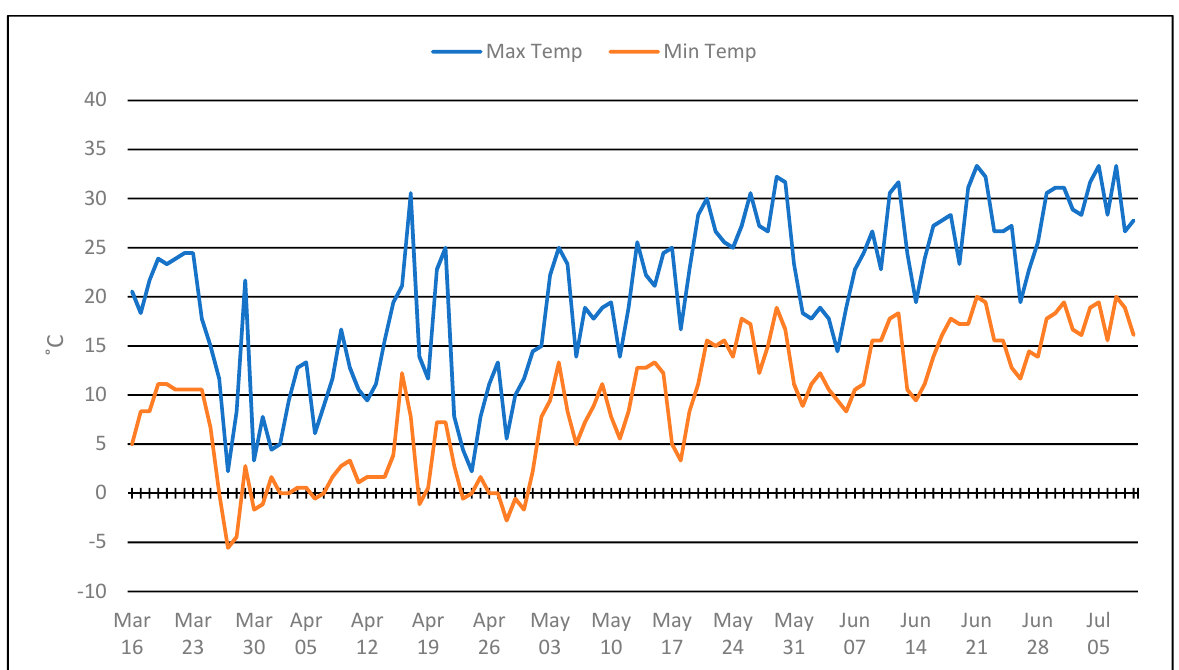
Figure 2. Mean total yield per plant through the harvest season for five short-day varieties in Trial 1 harvested in 2013 in an annual plasticulture production system in a cold climate region (central NY). High temperatures early in the season during flower and fruit development shifted production to the early part of the season.